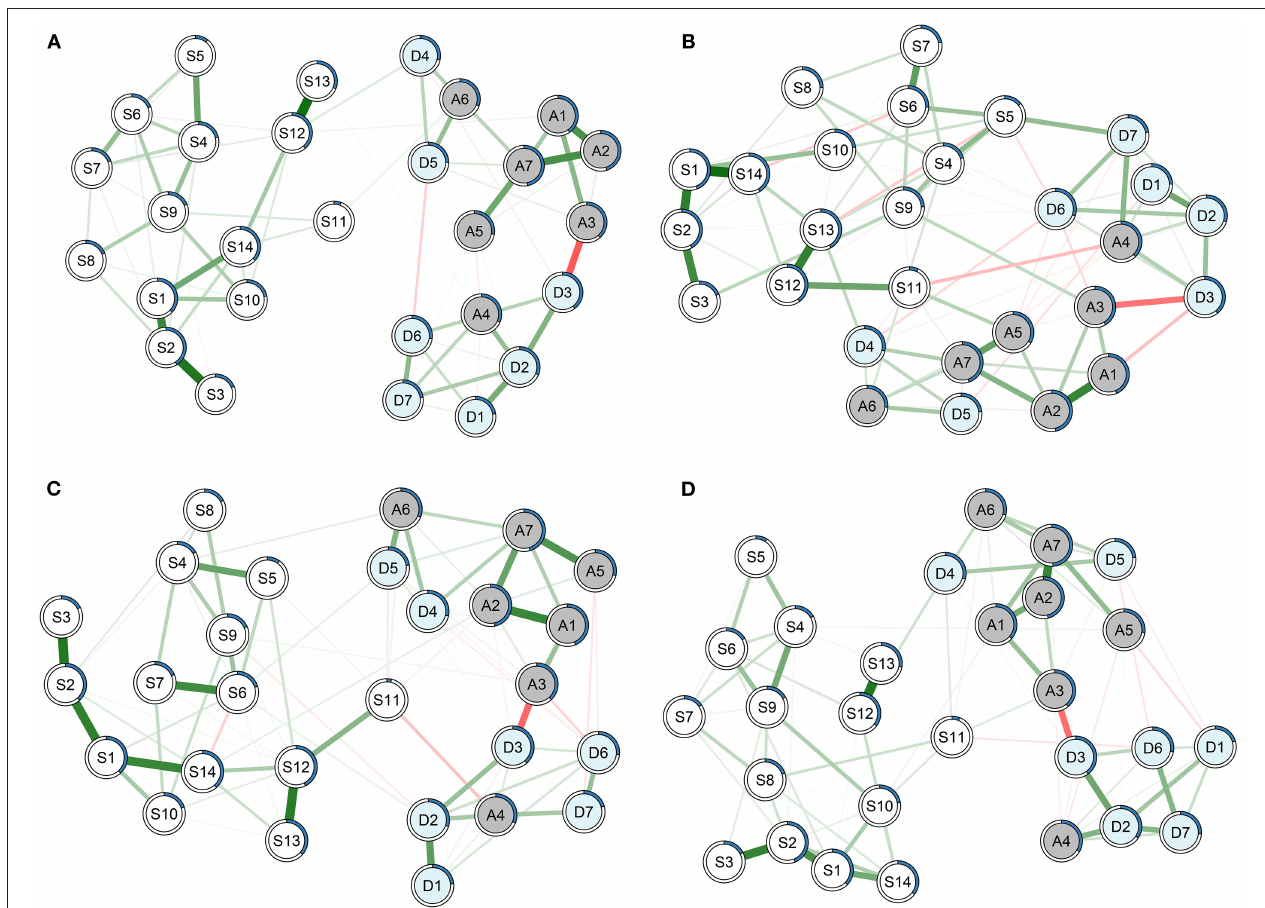
FIGURE 1 | Networks featuring 28 symptoms on the Hospital Anxiety and Depression scale questionnaire and the Pittsburgh Sleep Quality Index questionnaire for (A) males, (B) females, (C) participants infected with heterosexuality, and (D) participants infected with homosexuality. Green lines represent positive associations, and red lines negative ones. The thickness and brightness of an edge indicate the association strength. Node predictability is represented as a blue pie chart surrounding the node in the